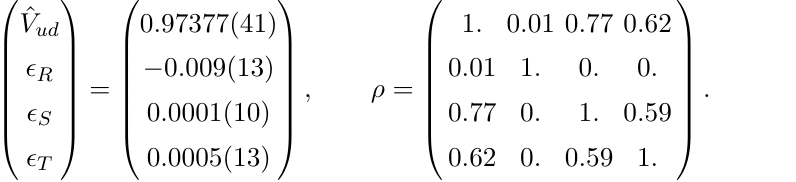
data can no longer disentangle g from effects of the new physics parameter (cid:15) , which A R encodes non-standard V + A interactions in the quark-level Lagrangian. Instead, a lattice determination of g has to be used to disentangle g and (cid:15) [73, 74]. In this analysis we A A R will use the FLAG’19 average g = 1 . 251 ± 0 . 033 [20]. With this additional lattice A